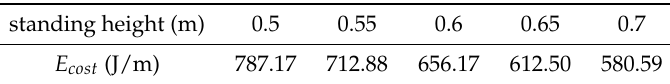
Figure 15. The energy consumptions with different standing heights. Table 6. E cost with different standing heights.